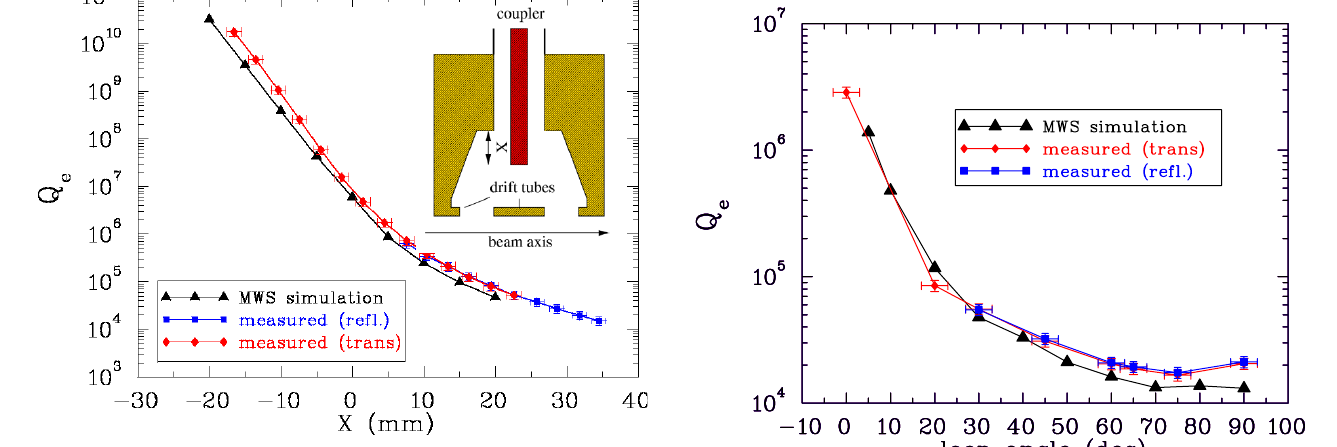
FIG. 17. (Color) Comparison between measurement and simu- lation of the external Q -value as a function of the loop angle.